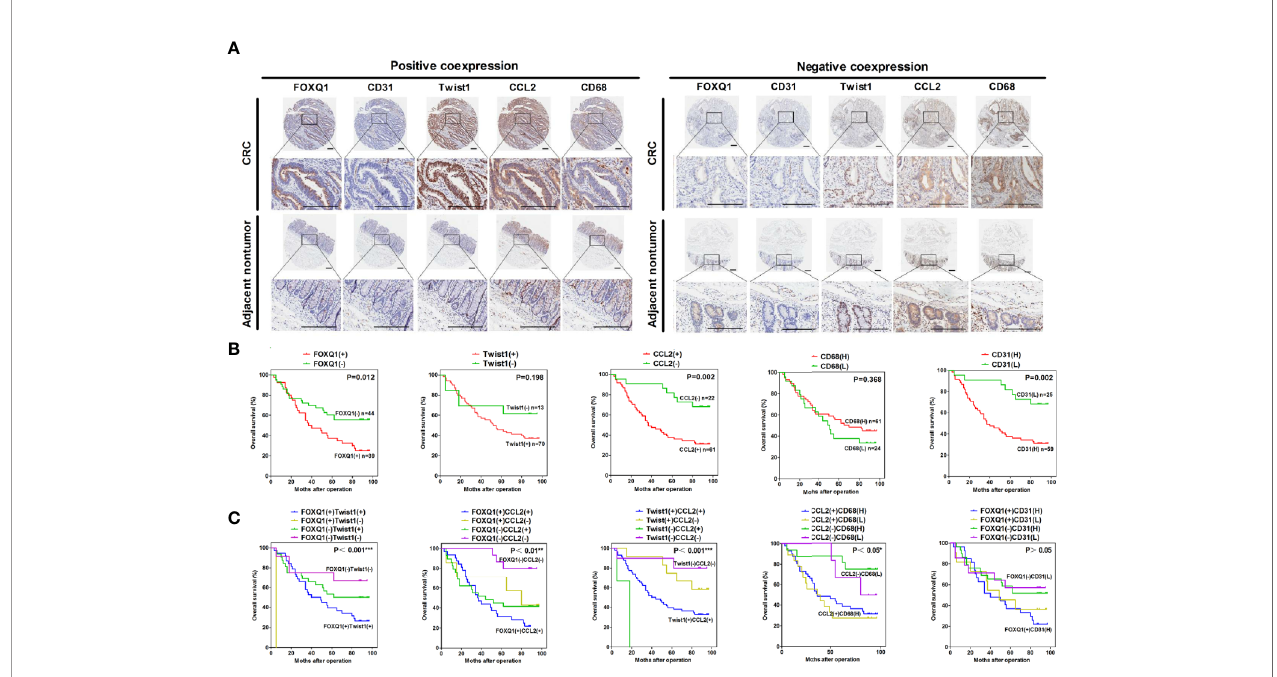
FIGURE 7 | FOXQ1 is associated with enhanced cancer angiogenesis and macrophage recruitment in human colorectal cancer (CRC). (A) Representative immunohistochemical images of FOXQ1, CD31, Twist1, CCL2, and CD68 positive co-expression and negative co-expression in human CRC tissues and adjacent nontumorous tissues. Scale bars represent 200 m m. (B) Kaplan-Meier survival analysis of CRC patients with positive expression of either FOXQ1 or CCL2 had shorter overall survival than those with negative expression of FOXQ1 or CCL2 in a cohort of 83 CRC patients. (C) Kaplan-Meier survival analysis of CRC patients with positive co-expression of both FOXQ1/Twist1, or FOXQ1/CCL2, Twist1/CCL2, or CCL2/CD68 had the shortest overall survival times compared with the corresponding single negative or double negative groups in the cohort of 83 CRC patients. * P <0.05, ** P <0.01, *** P <0.001 signi fi es a signi fi cant difference between the indicated groups (log-rank